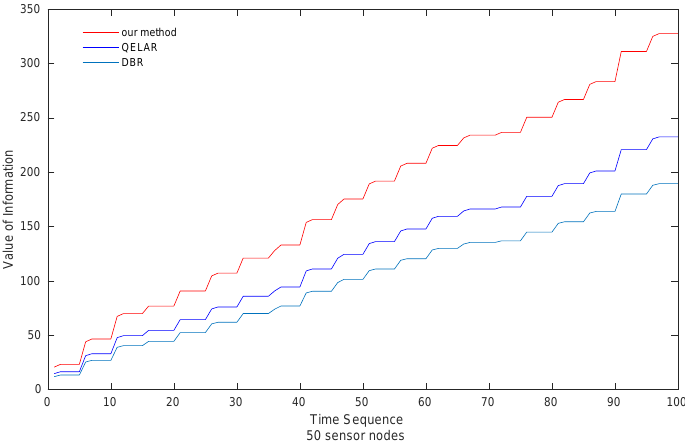
Figure 5. Value of Information obtained by sink nodes (50 sensor nodes).